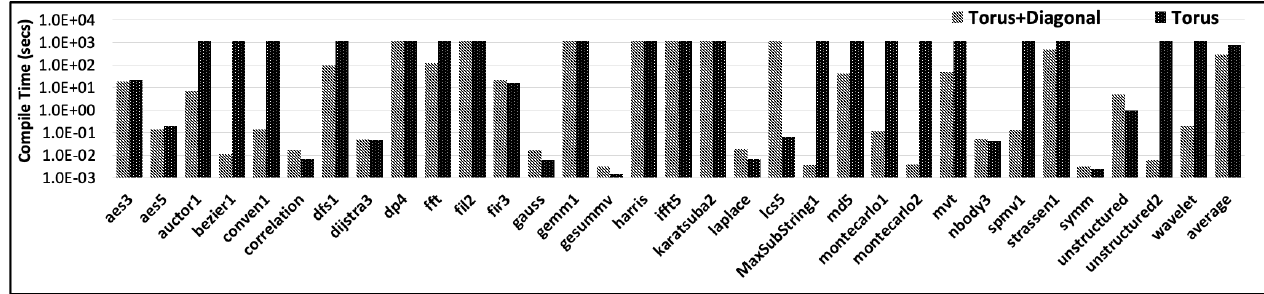
Figure 14. The compilation time of CFP-based context-fetching CGRA under torus and torus + diagonal interconnections.